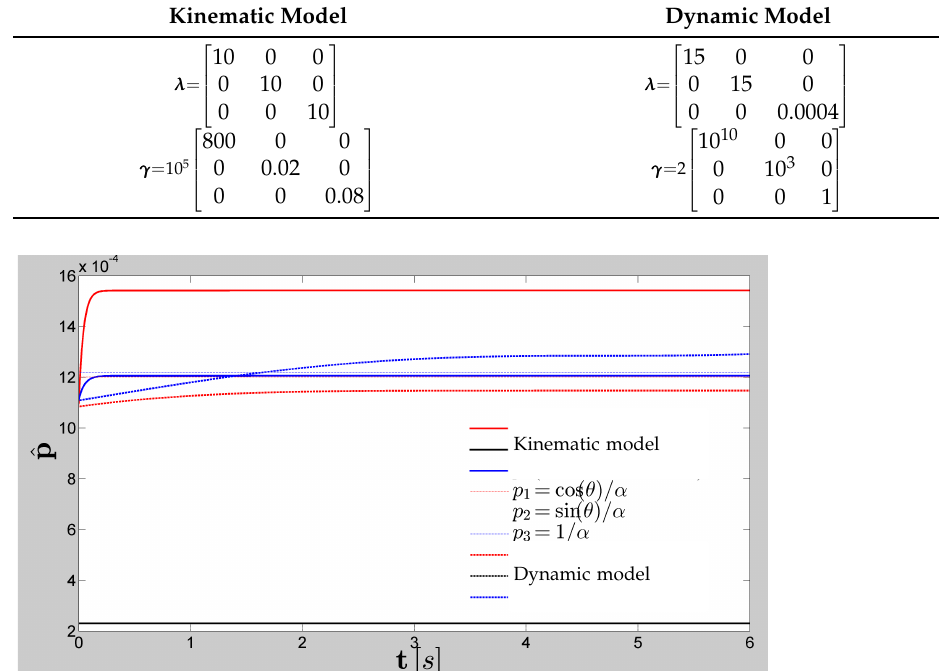
Figure 5. The estimated vision parameters for positioning.